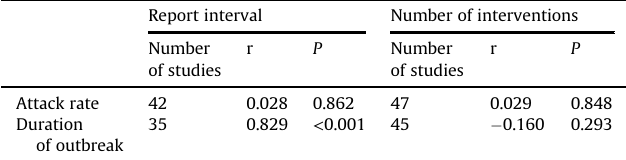
Table 1 Correlation between attack rate/duration of outbreak and some characteristics of outbreaks. Report interval